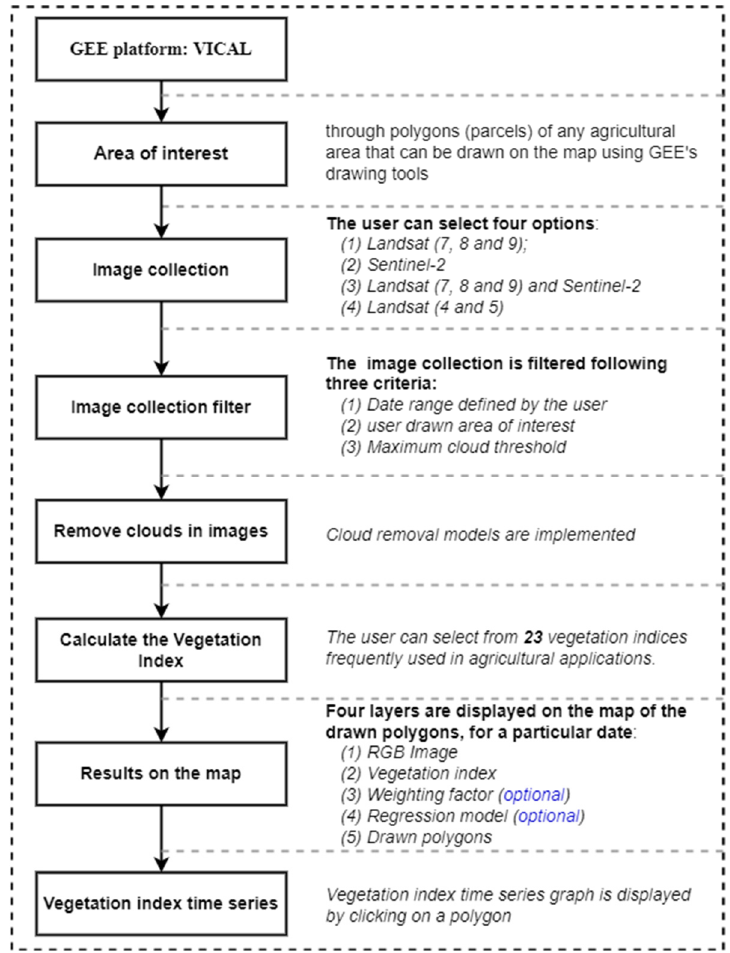
Figure 2. Methodology used by the VICAL tool to calculate vegetation indices. Here, VICAL used the atmospherically corrected land surface reflectance images Table 3. Image collection of Landsat and Sentinel-2 within the Google Earth Engine from Landsat (missions 4, 5, 7, 8 and 9, with images from 1982 to present) and Sentinel-2. Table 3 shows the properties of these image collections in the GEE. Thus, there are four